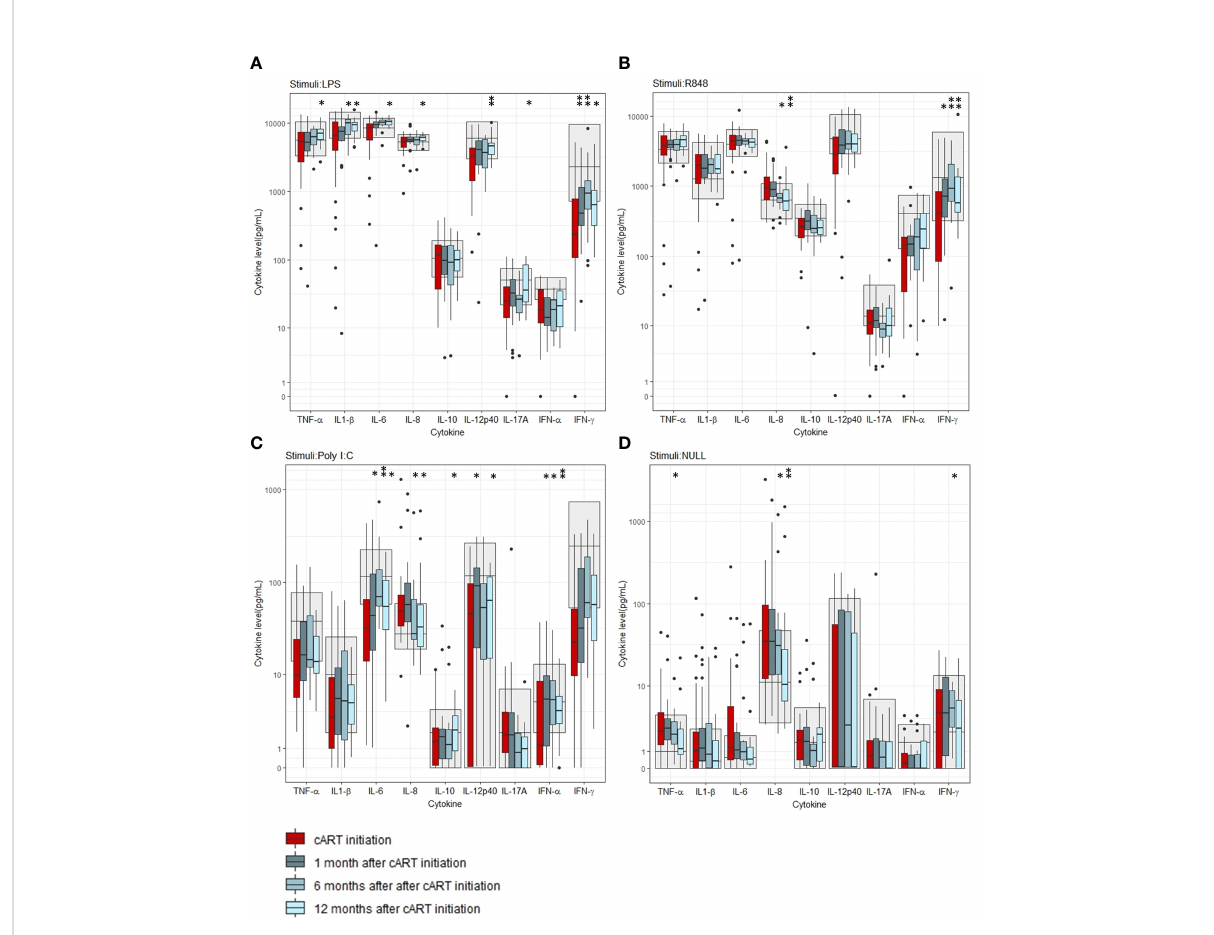
FIGURE 2 Induced cytokine concentrations before and after initiation of combination antiviral treatment (cART). (A) Stimuli: LPS, (B) Stimuli: R848, (C) Stimuli: Poly I:C, (D) Unstimulated (Null). Grey areas indicate 5-95% reference interval. * and ** indicates p-values < 0.05 and 0.005,